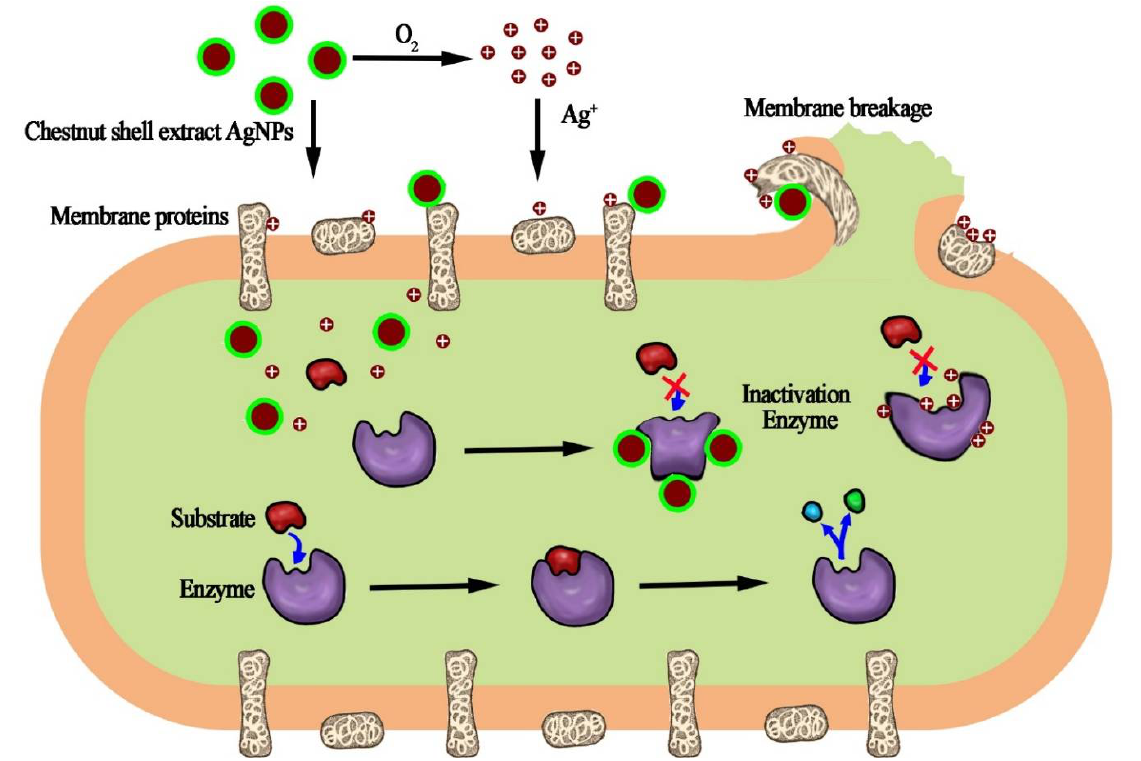
Figure 6. Schematic illustration of the possible antimicrobial mechanism of the functionalized chestnut-shell-extract AgNPs.